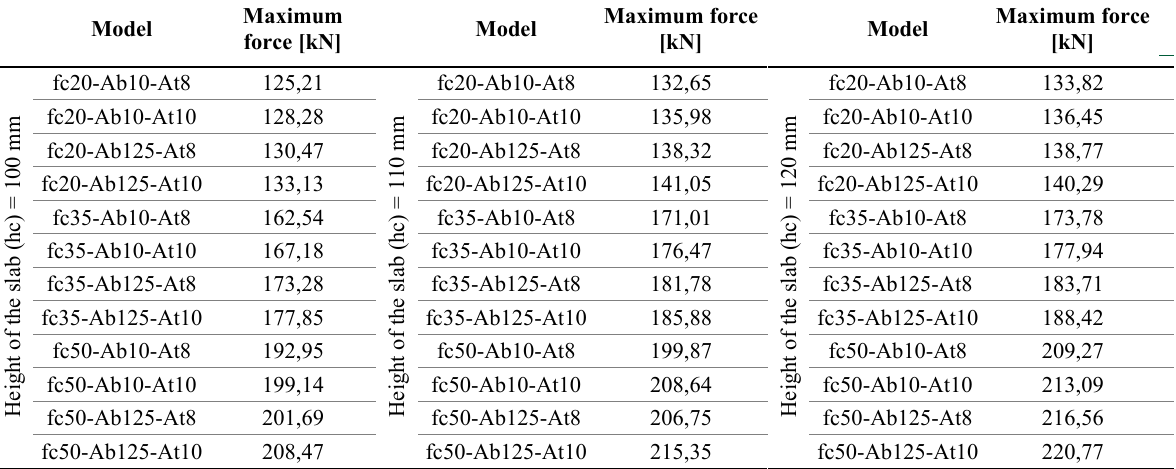
Table 3. Numerical results of the parametric study.